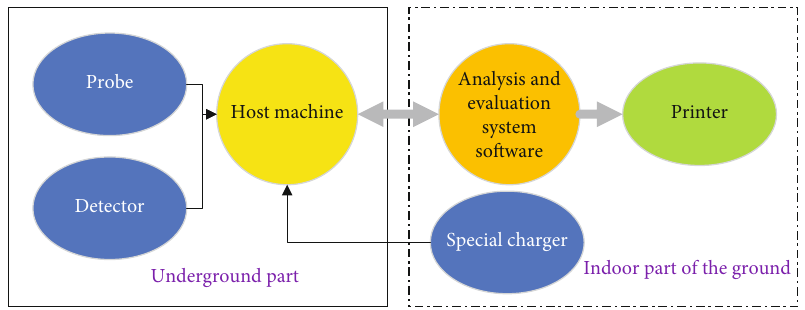
Figure 3: ZKXG30 mining borehole imaging track detection device (track) system structure